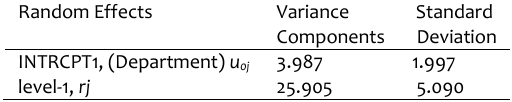
Table 4. Random Effects of the Empty